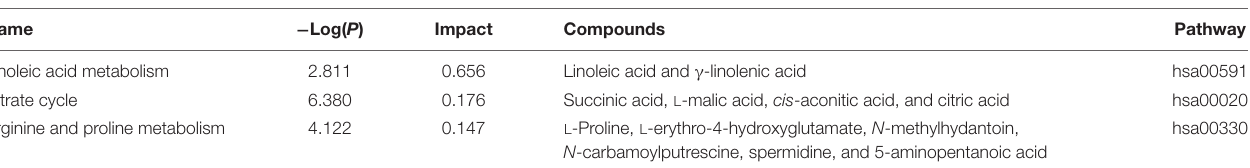
FIGURE 4 | Metabolic pathway analysis. (A) Histogram of metabolic pathways. (B) Bubble diagram of metabolic pathways. Each bubble in the bubble diagram represents a metabolic pathway. Color gradient and circle size indicate the significance of the pathway ranked by P -value (yellow: higher P -values and red: lower P -values) and pathway impact score (the larger the circle, the higher the pathway impact score). According to the − log( P ) value and pathway impact score, the top three metabolic pathways were identified by name. TABLE 2 | Analysis of the top three metabolic